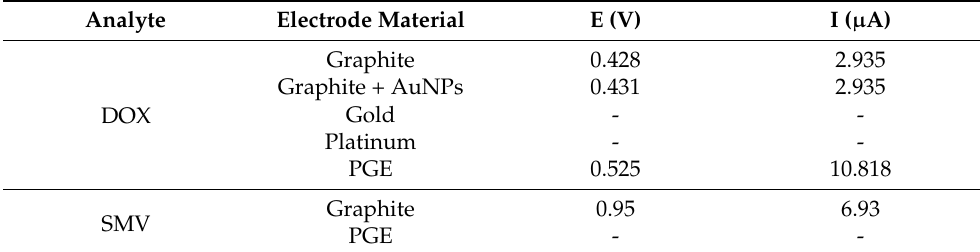
Table 1. Results obtained with different electrode materials for the oxidation of doxorubicin (DOX) (54.35 µ g/mL (100 µ M); acetate buffer (AB) pH 3.23) and simvastatin (SMV) (50 µ g/mL; Britton Robinson buffer (BRB) pH 5 + 40%